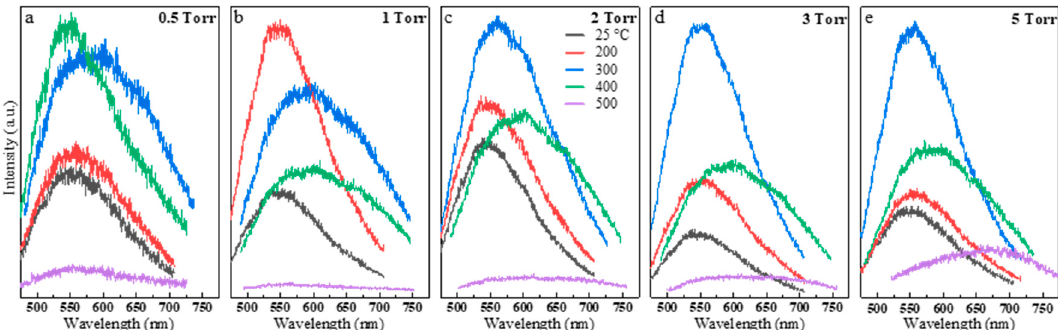
Figure 5. PL spectra showing the effect of baking temperature on the nanoparticles deposited at the indicated pressures ( a – e ). As the temperate rises to a suitable baking temperature of approximately 200–300 °C, the nanoparticles emission increases largely, and at higher temperatures (i.e., 500 °C) the intensity reduces again due to sintering and formation of larger particles.